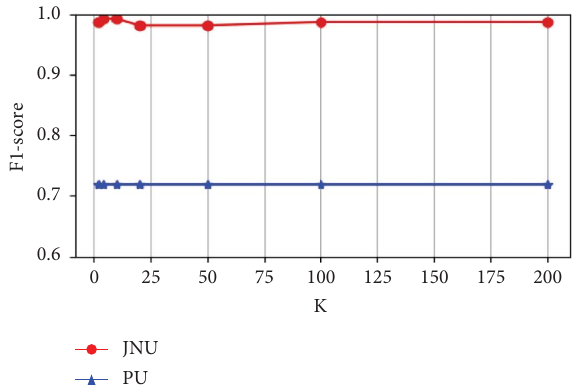
Figure 12: Te relationship between F 1-score and K by MW-CAVE (average of 5